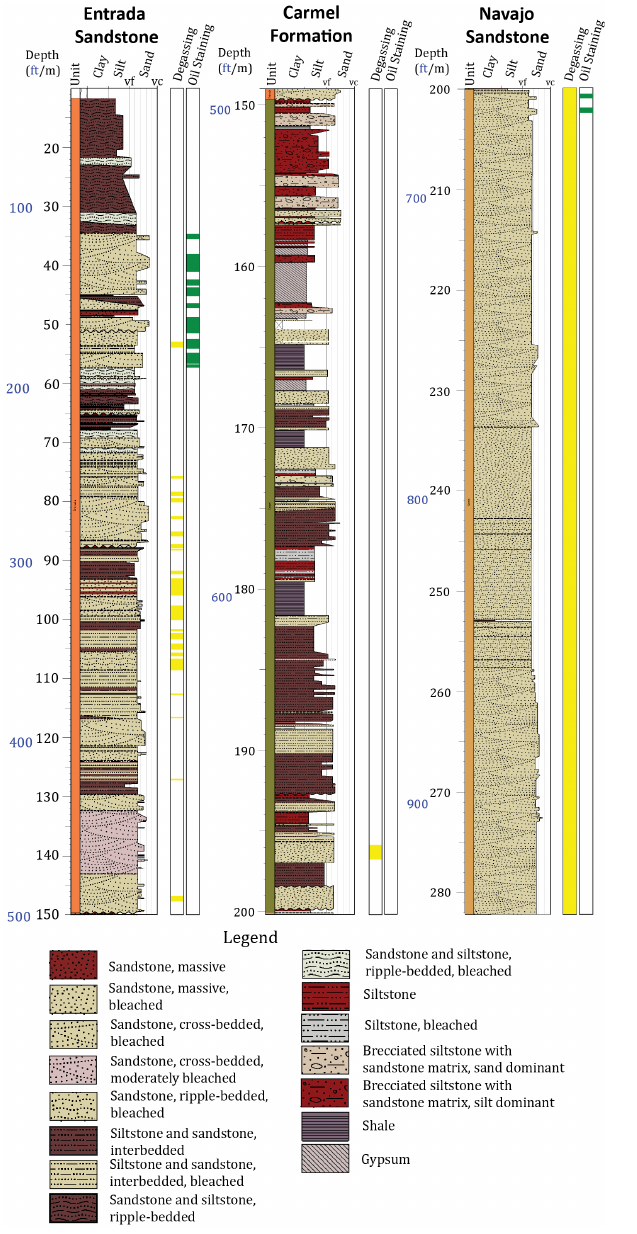
Figure 5. Sedimentary log of the core recovered from drill hole CO2W55 showing the main geological features of the three units, the Entrada Sandstone, Carmel Formation and Navajo Sandstone, transacted by the drill hole. Zones of CO 2 -degassing core and hy- drocarbon bearing zones are also